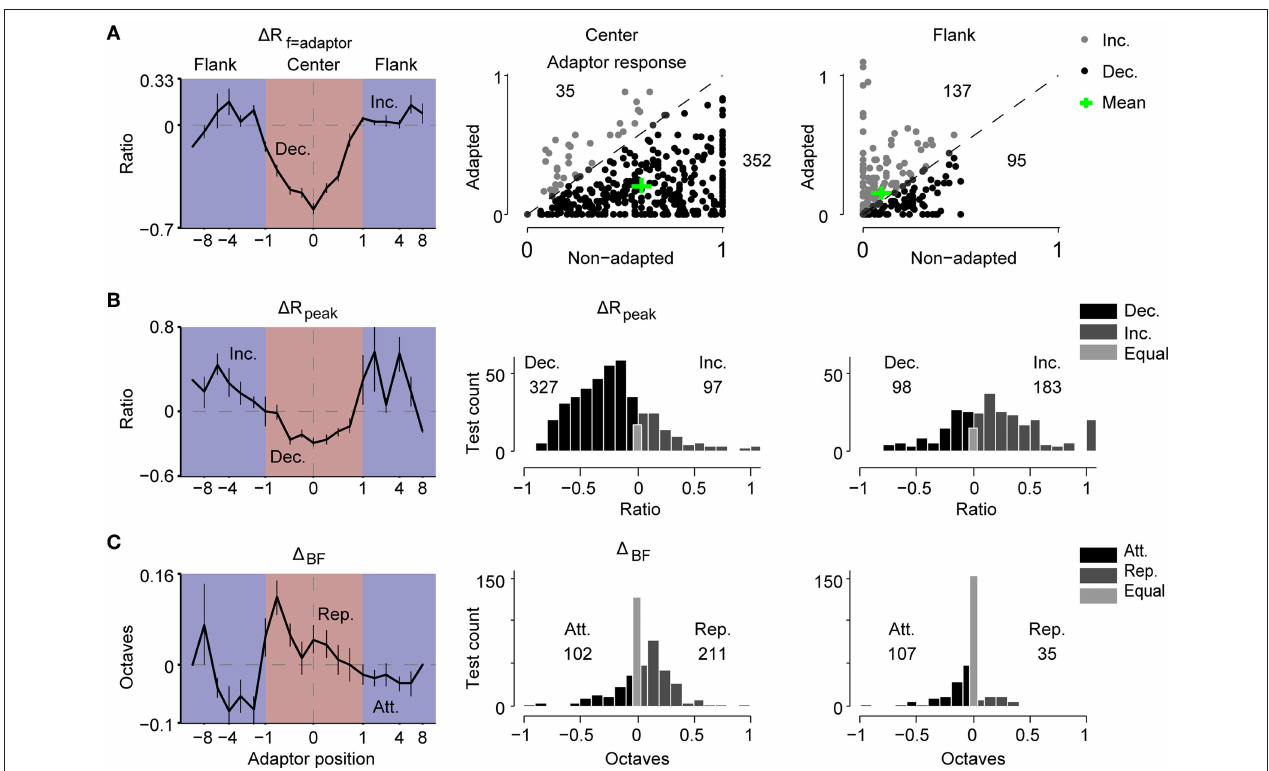
FIGURE 3 | The magnitude of the adaptive change of the RF displayed a center-surround pattern. (A) Left: the profile of the change ratio of the responses at the adaptor ( 1 R f = adaptor ) with respect to the adaptor position. 1 R f = adaptor was normalized by the individual peak response of the non-adapted tuning. Middle and right: response at the adaptor frequency in the adapted condition against the original condition for each test (normalized by the individual peak response of original tuning) when the adaptor was in the center (middle panel) or on the flank of the RF (right panel). The mean value is indicated by a green cross. The number of tests showing increasing (gray) or decreasing (black) responses is annotated above or below the diagonal, respectively. (B) Left: the profile of the change ratio of the maximal response ( 1 R peak ) with respect to the adaptor position. 1 R peak was normalized by the individual maximal response of original tuning. Middle and right: the distributions of 1 R peak when adaptors were in the center (middle panel) or on the flank (right panel). The numbers denote the number of tests with decreased (Dec.) and increased (Inc.) responses. (C) Left: the profile of the shift magnitude of the BF ( 1 BF ) with respect to the adaptor position. Positive values indicate repulsive shifts (Rep.) while negative values represent attractive shifts (Att.). Middle and right: the distributions of 1 BF when the adaptors were in the center (middle panel) or on flank of the RF (right panel). The numbers denote the number of tests with attractive and repulsive shifts. All error bars indicate the mean ± SE.